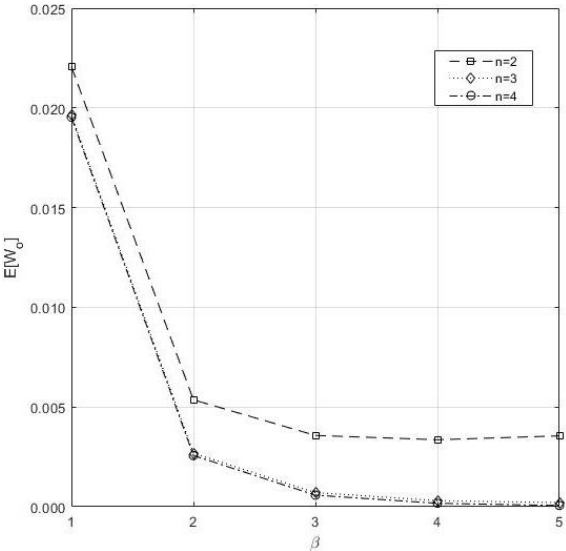
Figure 3. Impact of n and β on the E [ W o ]